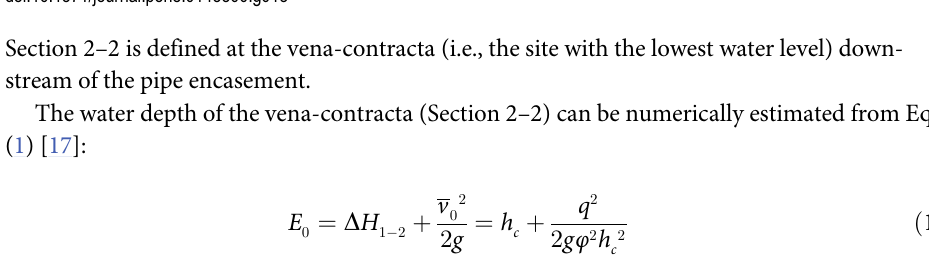
Fig 13. Layout of cross-sections used for calculating total water head and Froude number.